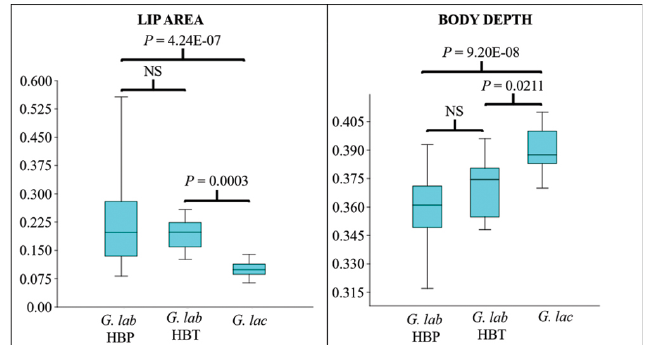
FIGURE 8 | Kruskal-Wallis box-plot and test for the lip area (Hc = 29.19, P = 4.59E-7) and the body depth (Hc = 30.78, P = 2.07E-7). The significance values for the peer-to-peer post-hoc tests are presented directly in the figure. G. lab = Gymnogeophagus labiatus , G. lac = G. lacustris .